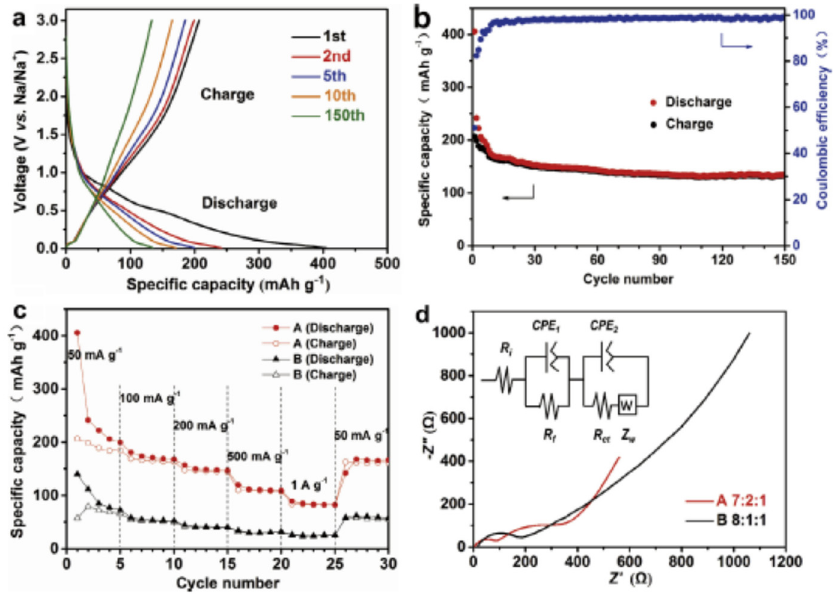
Figure 18. Various active material ratios of A (7:2:1) and B (8:1:1) were used to check the electro- chemical performance of the MgFe 2 O 4 microbox electrodes. ( a ) Charge/discharge curves and ( b ) cyclic performance of sample A at a current density of 50 mA g − 1 ; ( c ) rate performance, and ( d ) Nyquist plots of samples A and B [87]. Reproduced with permission.